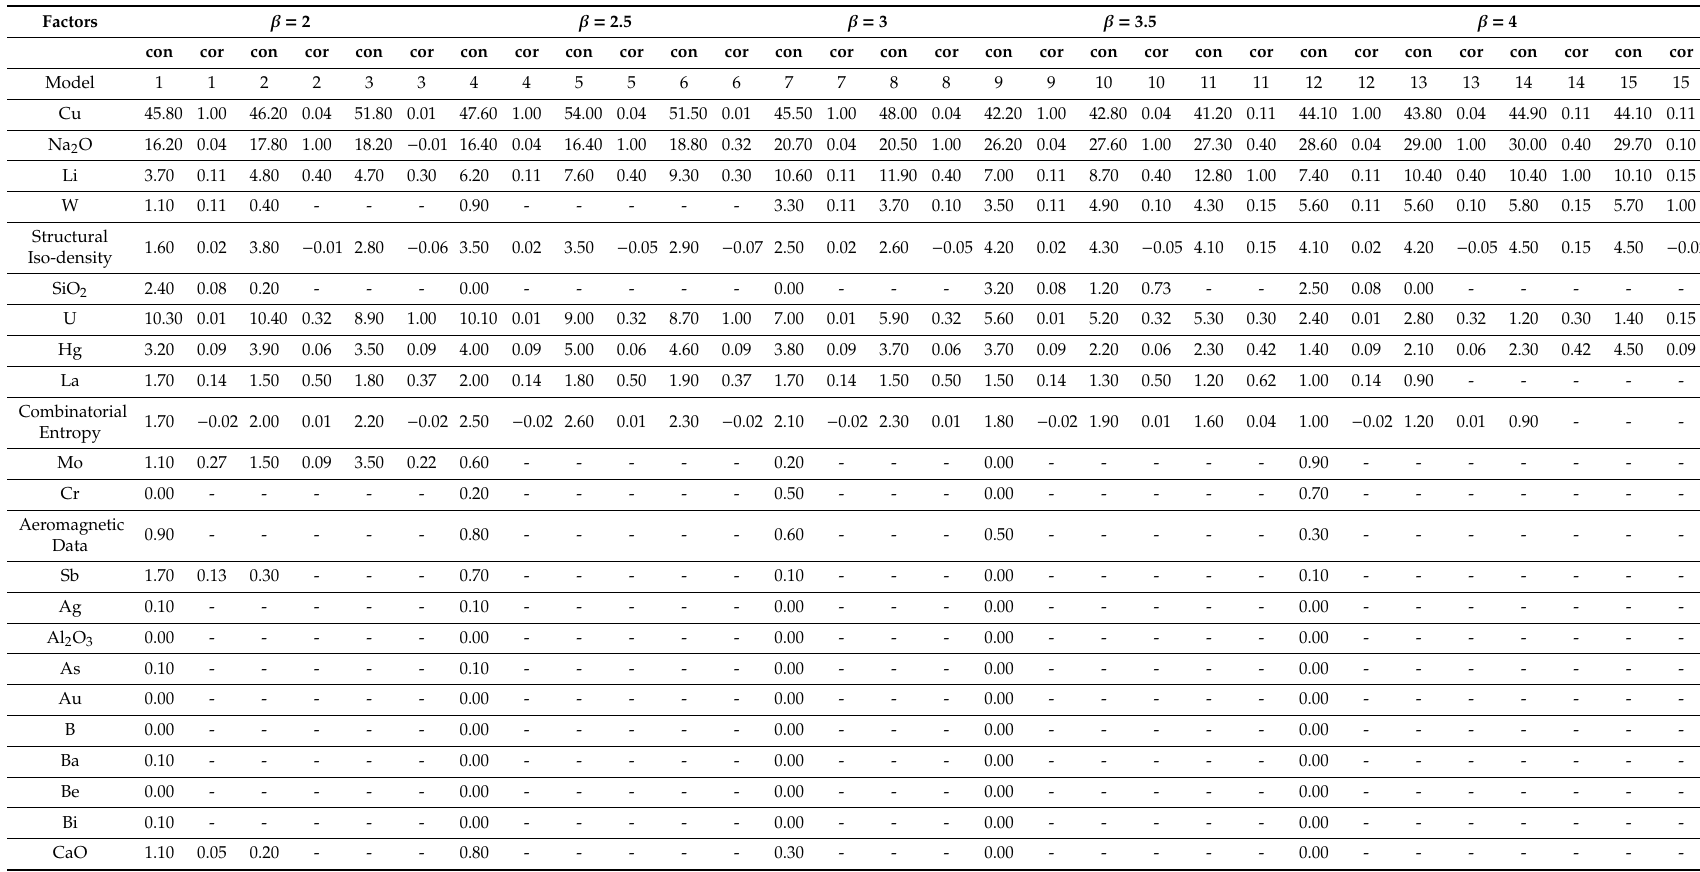
Table A1. Optimization of the selection process of ore-controlling factors and β